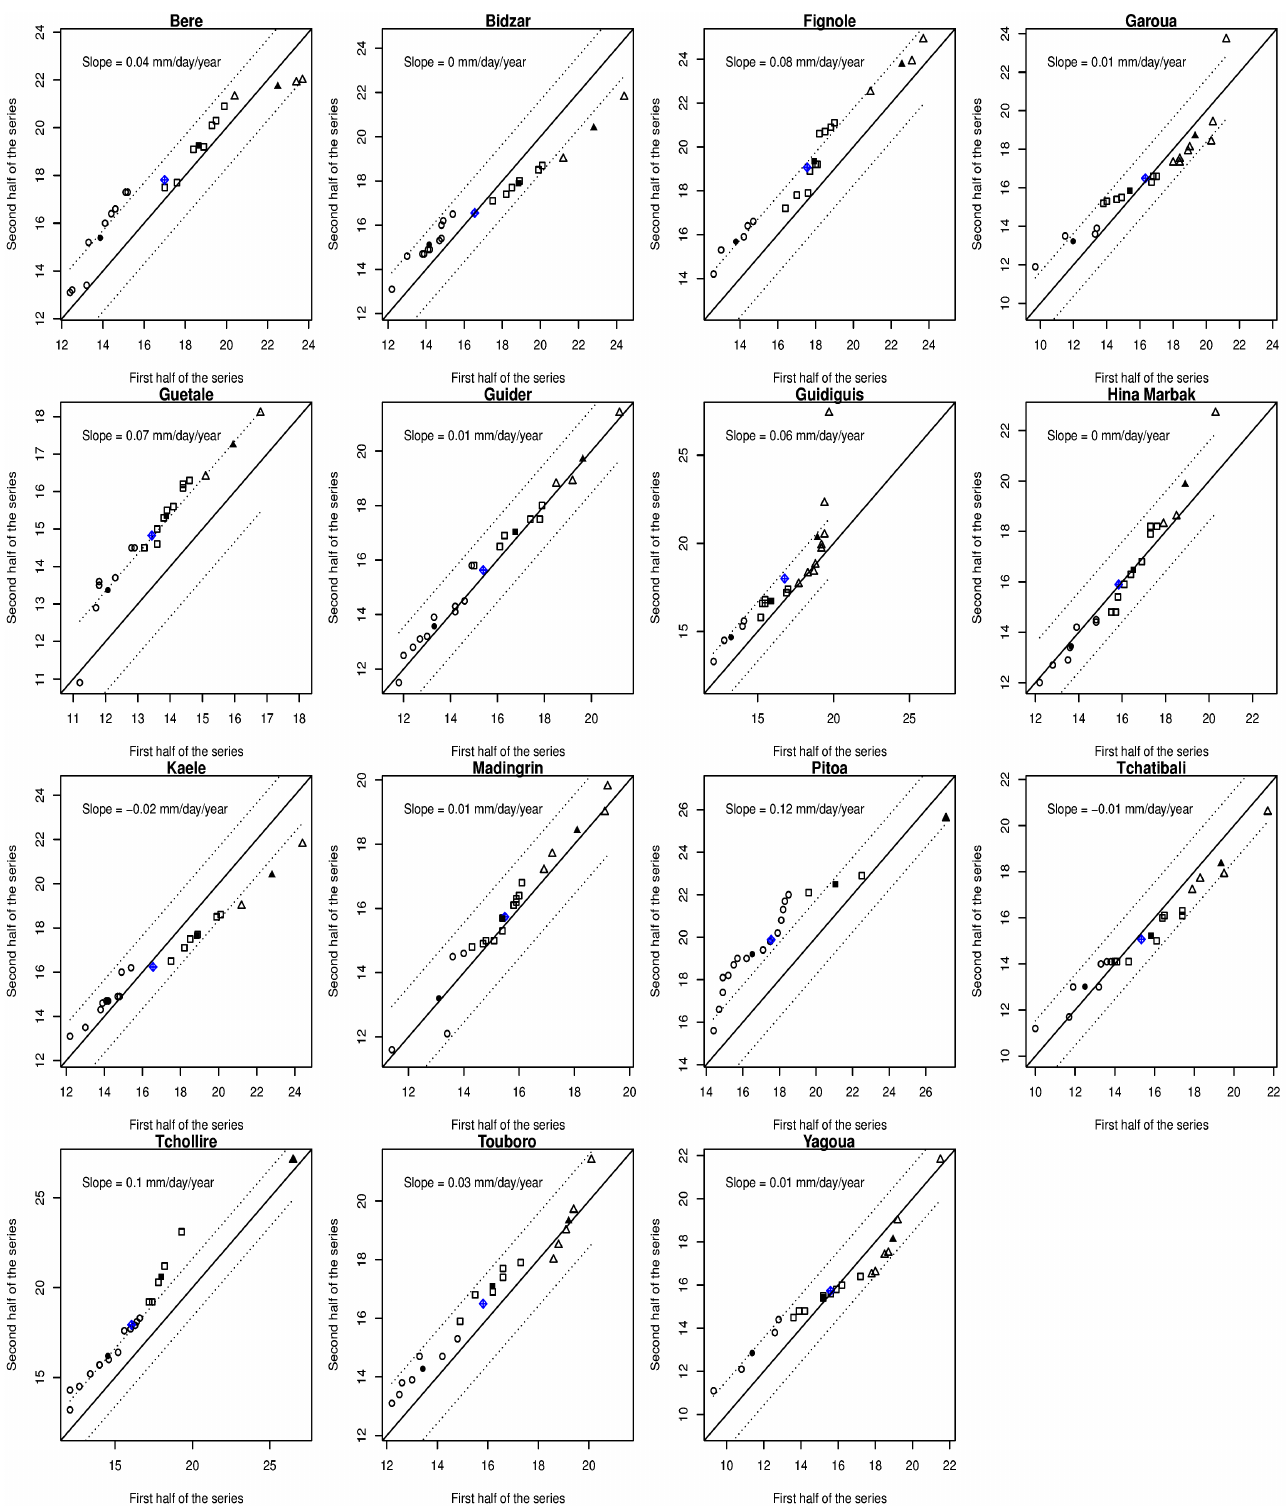
Figure 5. As in Figure 4, but for SDII.